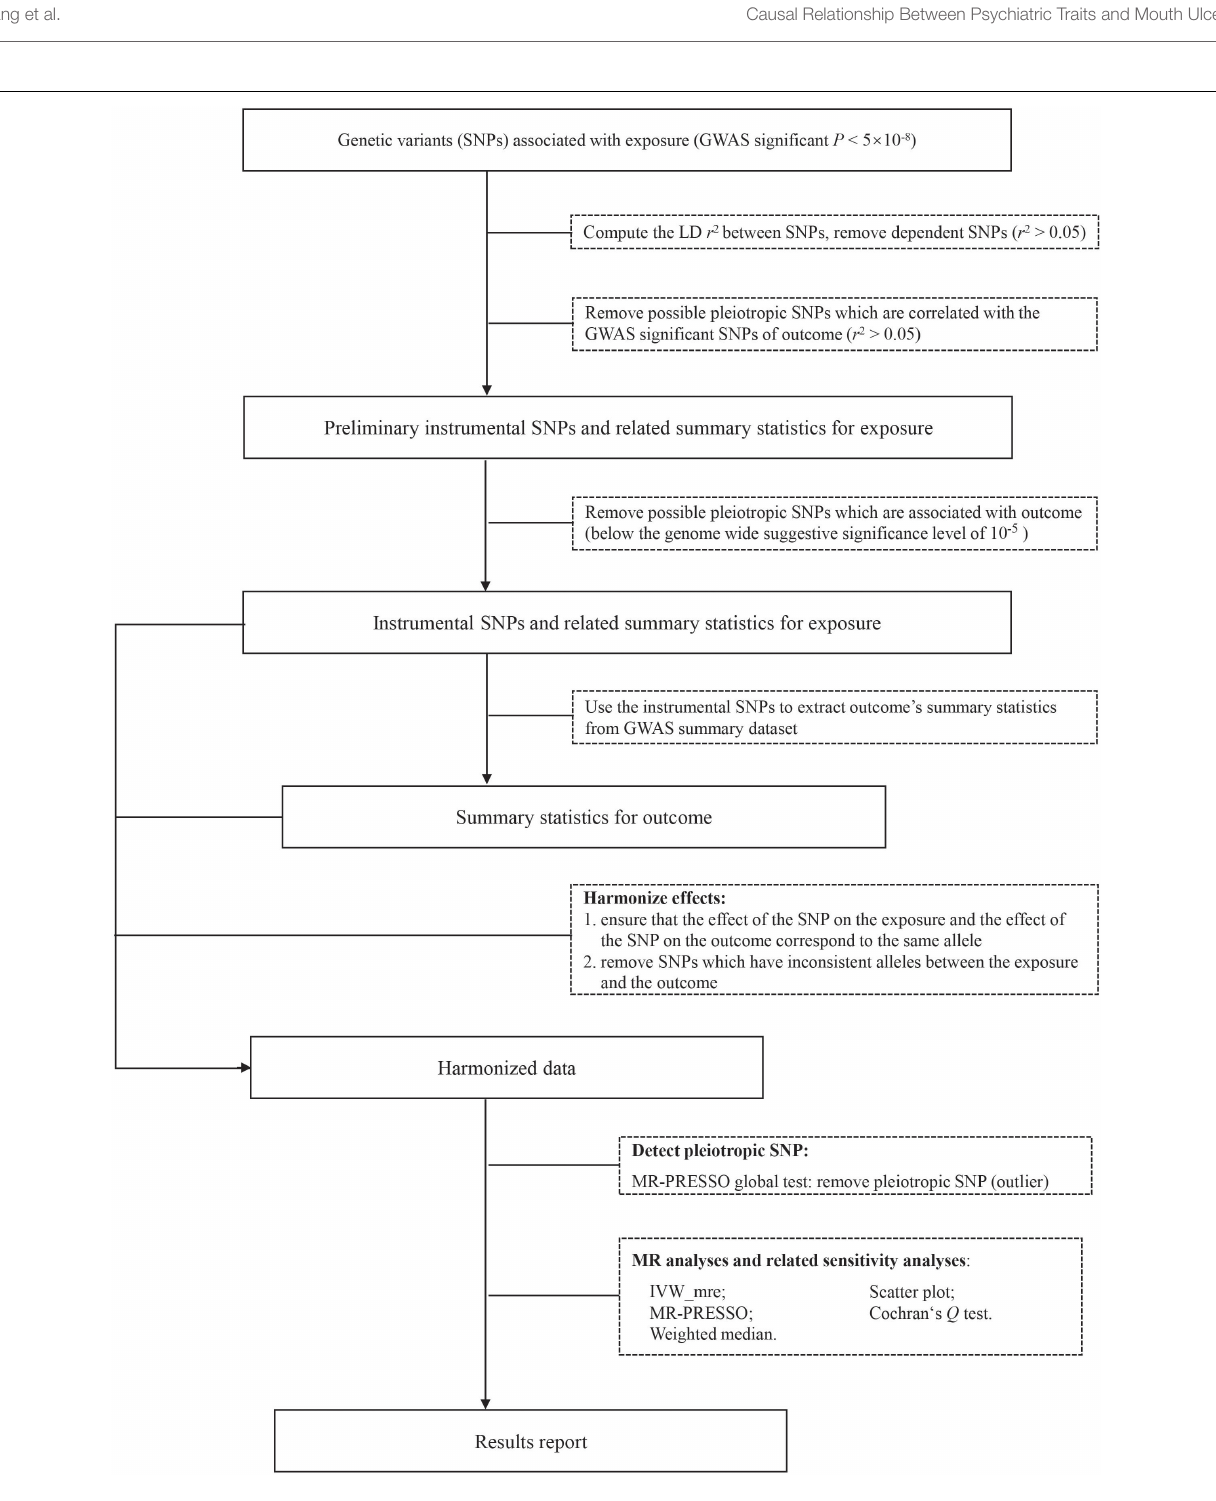
FIGURE 1 | The analysis flowchart of this study. IVW_mre, inverse variance weighted multiplicative random effects; MR-PRESSO, Mendelian randomization pleiotropy residual sum and outlier.